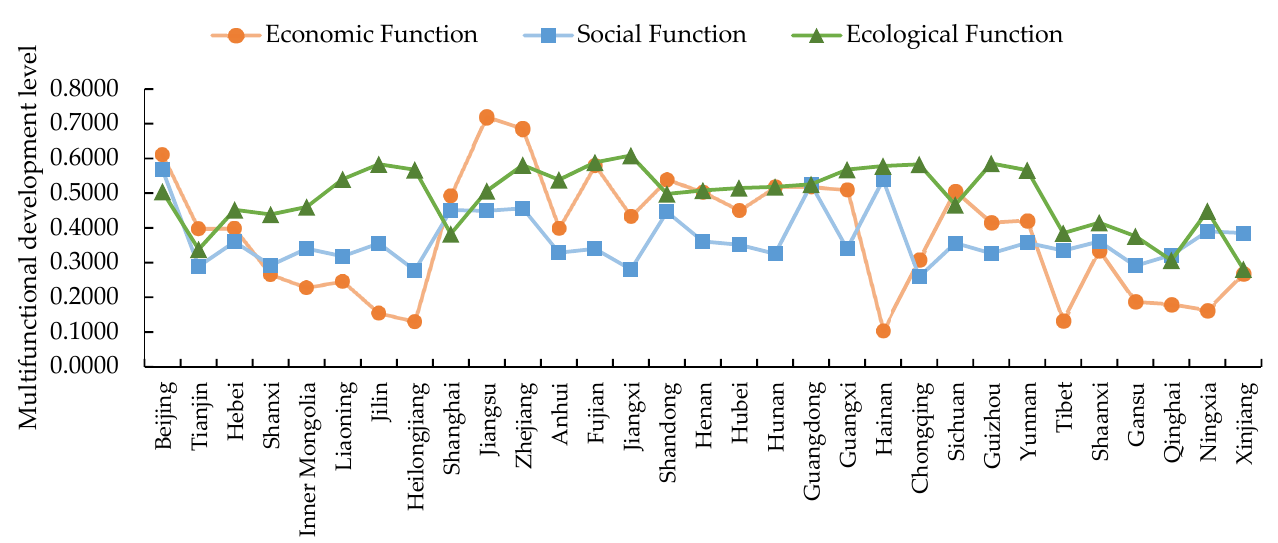
Figure 1. The changing trend of the evaluation results at multi-functional development level of green infrastructure in various provinces of China.